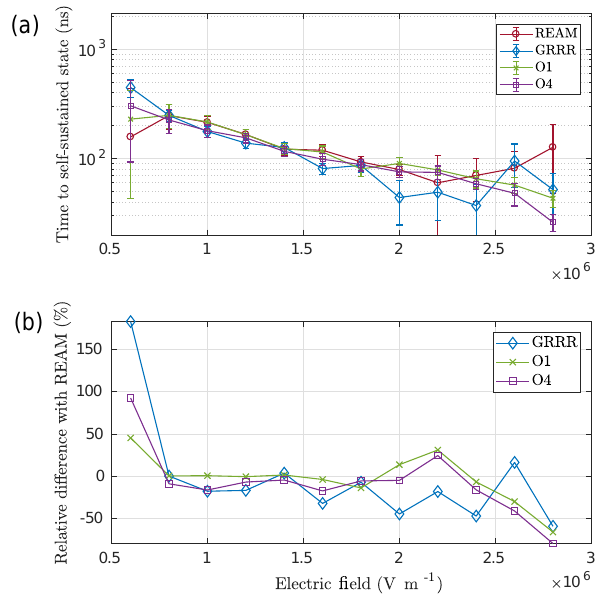
Figure 5. (a) Time to self-similar state as function of ambient elec- tric field for each of the codes included in this study. (b) Relative difference with respect to